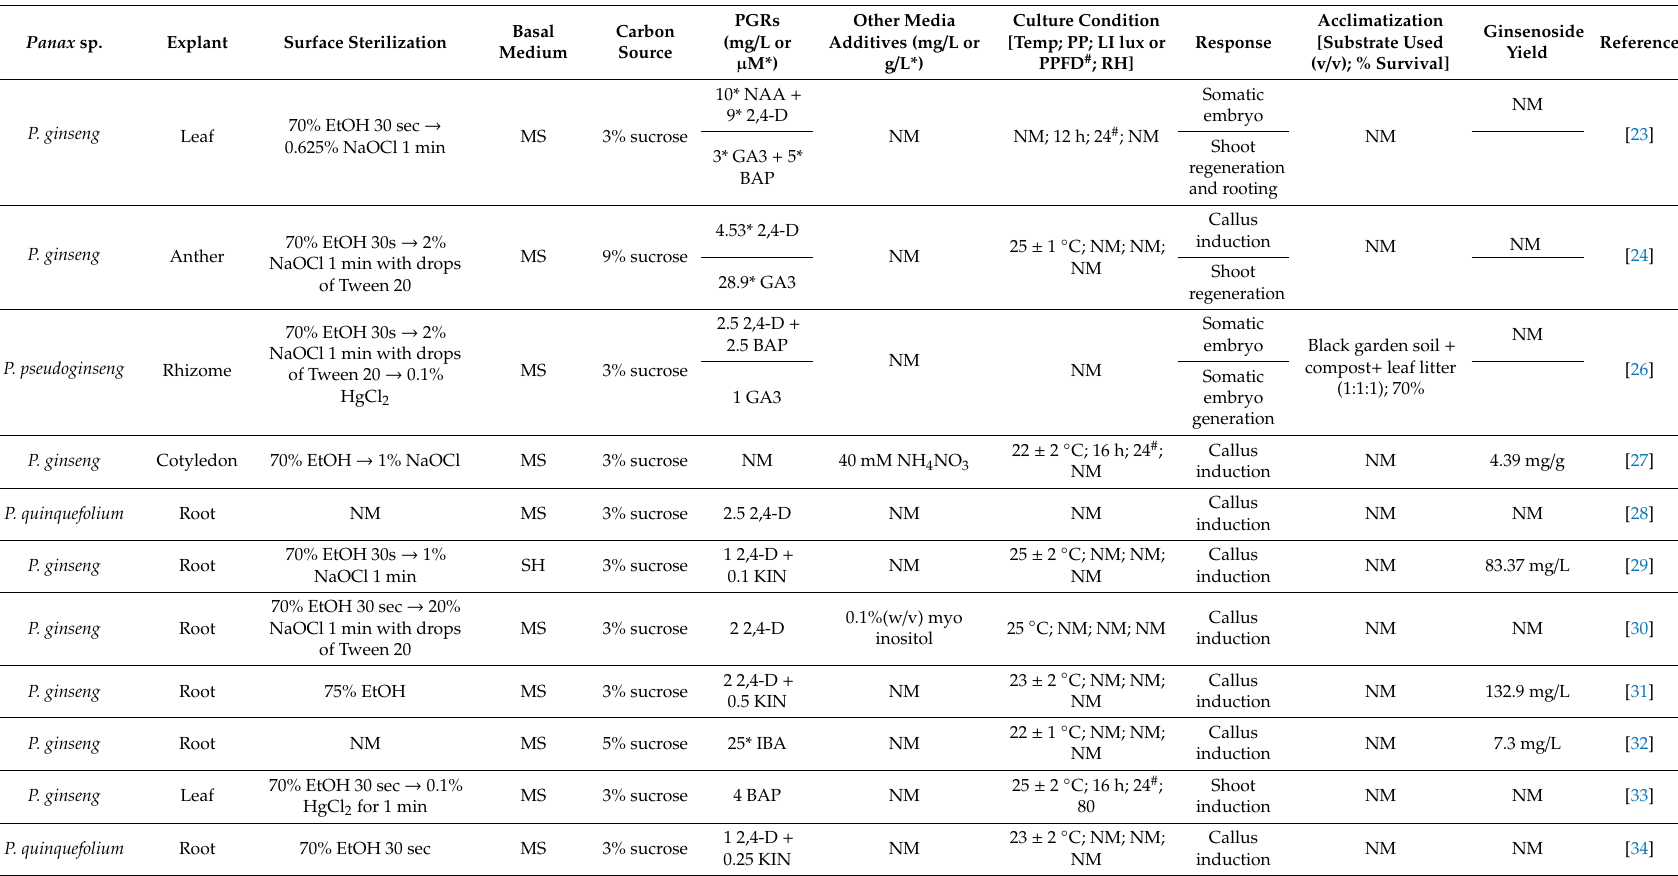
Table 1. Factors involved in and their influence on ginsenoside production during indirect organogenesis. Panax